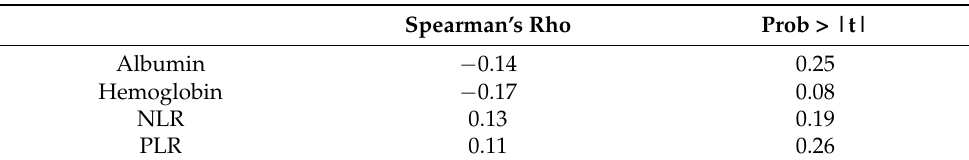
Table 2. Correlation analysis of the bone marrow-to-liver SUV ratio (BML) with serum laboratory tests. NLR: neutrophil-to-lymphocyte ratio; PLR: platelet-to-lymphocyte ratio.